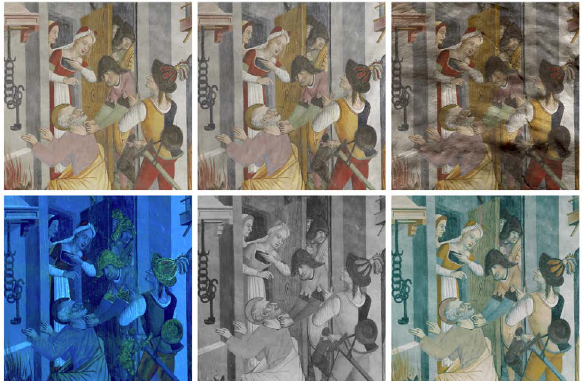
Figure 1: Example of TP documentation on The Denial of Saint- Peter fresco from the case-study of Notre-Dame des Fontaines chapel ; respectively VIS, semi-RAK (from right), RAK (from down), UVf, IR and IRfc